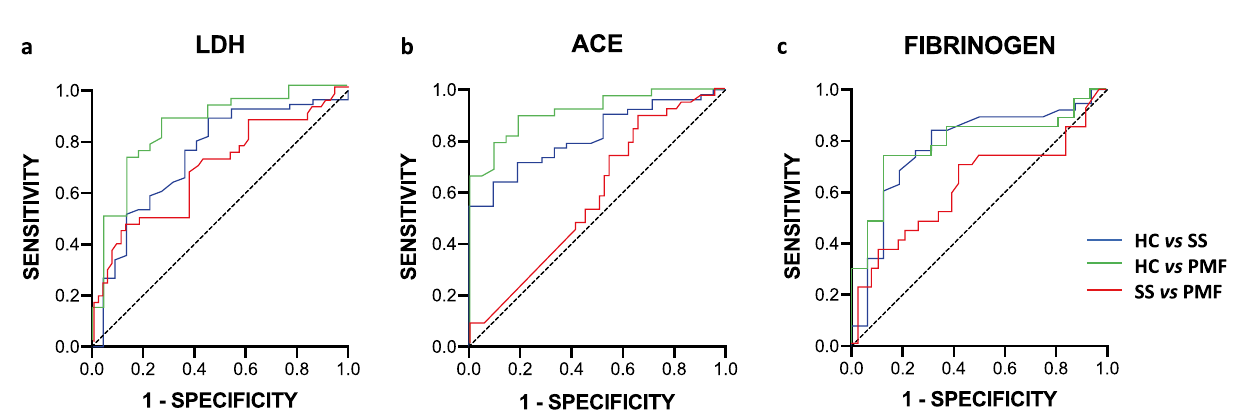
Figure 2. ROC curves using LDH, ACE and fibrinogen biochemical markers for predictive ES silicosis status between studied groups. ( a ) LDH, ( b ) ACE and ( c )